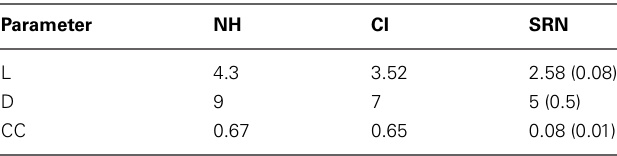
Table 3 | Summary of results for simulated random network distribution